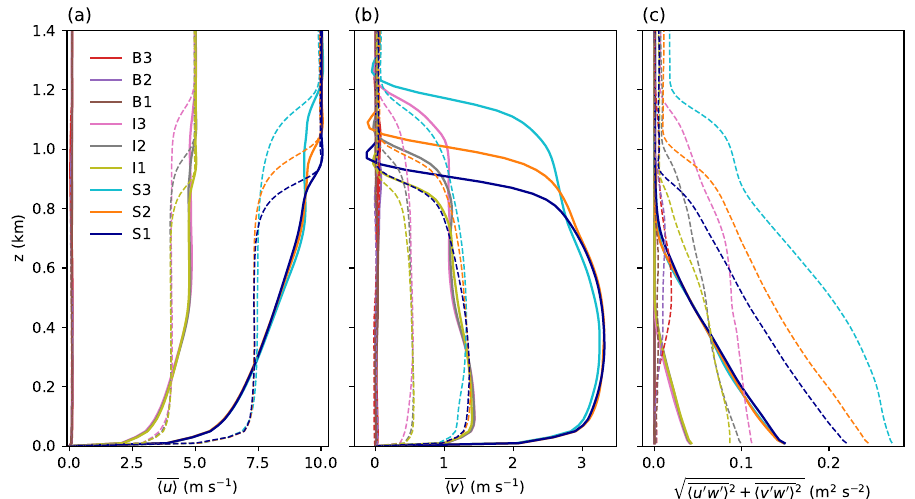
Figure 1. Profiles of temporally and horizontally averaged ( a ) u velocity, ( b ) v velocity, and ( c ) vertical turbulent momentum flux. The dashed and solid lines indicate results averaged for the 600 s before t = t c and for the last 600 s,